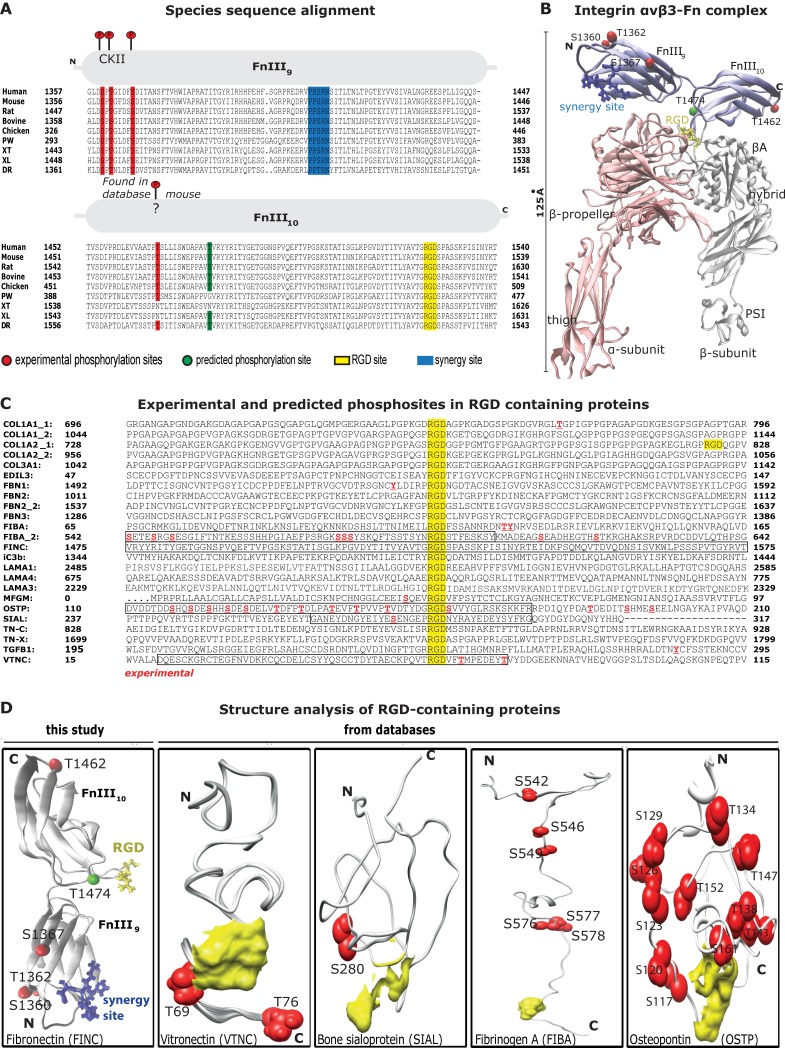
Putative phosphorylation sites around the RGD-binding site are highly conserved.A: Sequence alignment of the FnIII9-10 for various species, namely human, mouse, rat, bovine, chicken, pleurodeles waltl (PW), xenopus tropicalis (XT), xenopus laevis (XL) and danio rerio (DR). Experimentally determined phosphorylation sites for human fibronectin are depicted in red, predicted phosphorylation sites are shown in green. B: Structure of αvβ3 integrin headpiece docked to FnIII9-10. RGD (yellow) and synergy site (blue) are shown in sticks representation. C: Sequences of 20 RGD (yellow) containing human integrin ligands were analyzed -/+ 50 residues around their RGD. Shown are experimentally verified phosphor-sites. Black boxes indicate the sequences of the analyzed structures in D. D: The structures of fibronectin, vitronectin, bone sialoprotein, fibrinogen A and osteopontin were analyzed in proximity of their RGD (yellow) sites and experimentally verified phosphorylated sites (red) are highlighted.